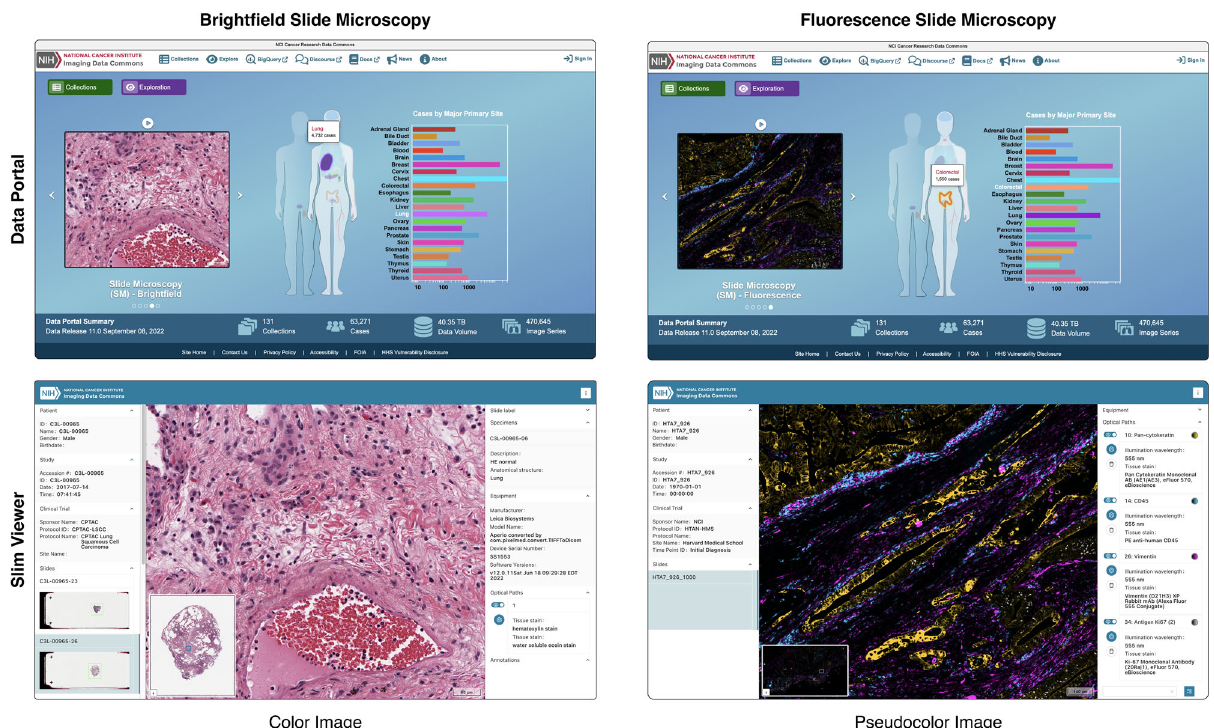
Fig. 2 | Use of Slim as slide microcopy viewer of the NCI Imaging Data Commons. Screenshots of the NCI Imaging Data Commons data portal (top) and of the Slim viewer (bottom). Shown are a true color image of a hematoxylin and eosin stained lung squamous cellcarcinoma specimenfrom the ClinicalProteomic